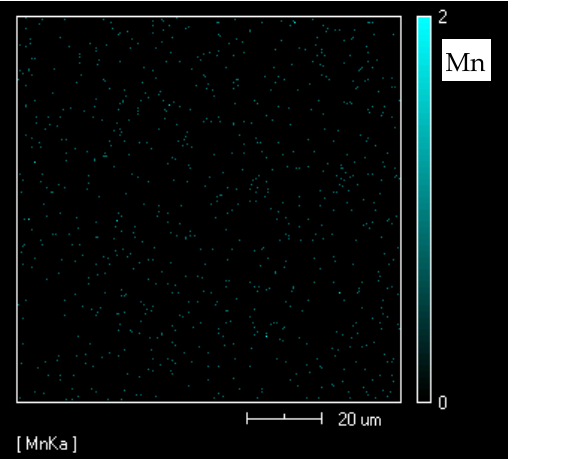
Figure 6. SEM images of AZ80 alloy and its distributions of elements in A-zone.